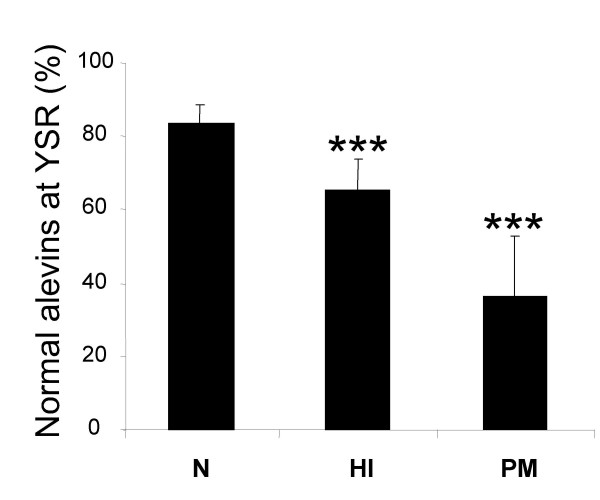
Percentage of normal alevins at yolk sac resorption (mean ± 95% confidence interval) observed after fertilizing eggs of females subjected to natural ovulation (N, n = 25), hormonal induction of ovulation (HI, n = 33) and photoperiod manipulation of ovulation (PM, n = 17). Significantly different from natural ovulation at p < 0.0001 (***).